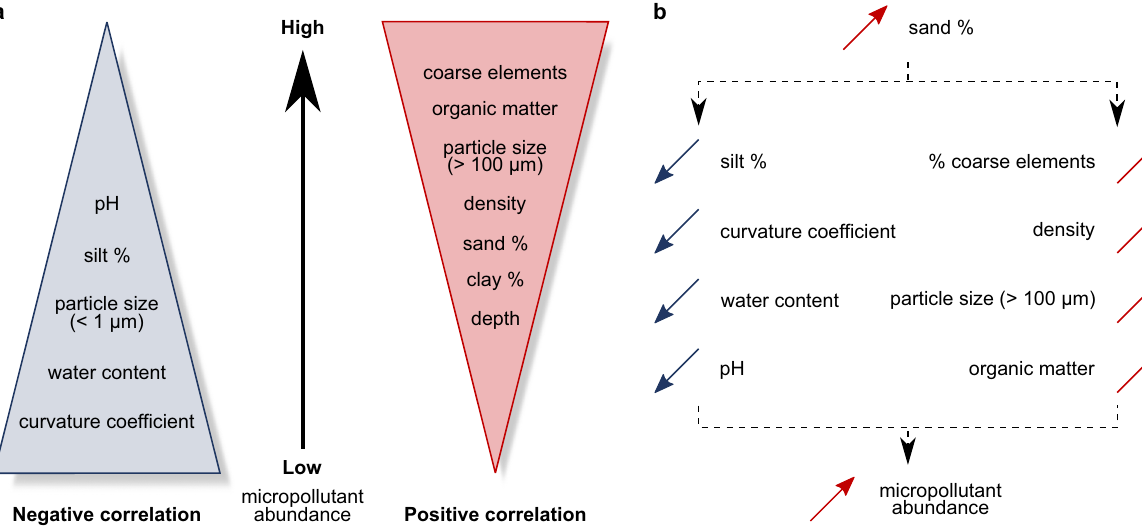
Fig. 4 Proposed model for soil physico-chemical parameters affecting micropollutant abundance in a road runoff in fi ltration pond. a Soil properties could be divided into those that are negatively (blue) and positively (red) correlated with micropollutant abundance. b A strategy is proposed to increase micropollutant trapping in the soil of an in fi ltration